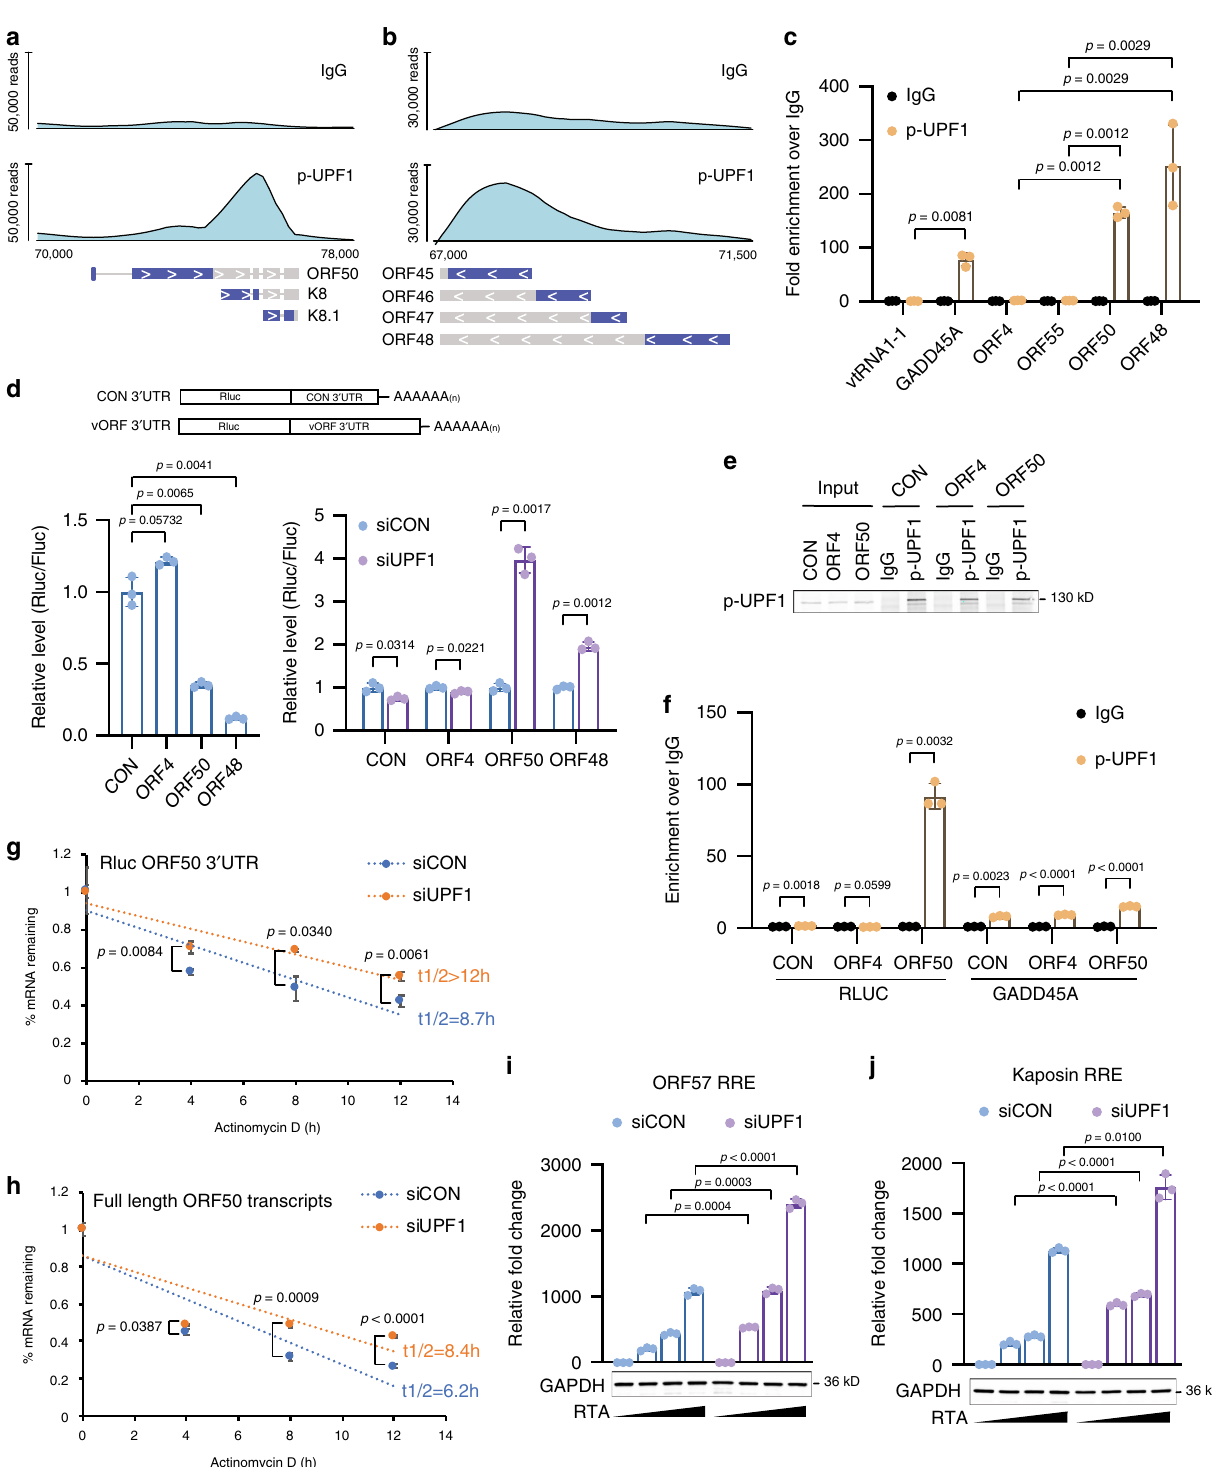
t1/2=6.2ht1/2=8.4ht1/2=8.7ht1/2>12h Fig. 5 NMD targets ORF50 mRNA via its 3 ’ UTR to repress RTA transactivation. a Distribution of p-UPF1 fRIP-seq reads on loci of ORF50-K8.1 gene cluster. b Distribution of p-UPF1 fRIP-seq reads on ORF45-ORF48 gene clusters. c p-UPF1 fRIP-qPCR analysis of indicated viral genes in TREx-BCBL1-RTA cells 48 h post-Dox induction. d Luciferase assay of reporters with control or viral 3 ’ UTR. e Western blot of p-UPF1 fRIP in cells transfected with luciferase reporter containing a control, ORF4 or ORF50 3 ’ UTR. f p-UPF1 fRIP-qPCR analysis of luciferase reporter with control, ORF4 or ORF50 3 ’ UTR. g , h Half-life measurement of the luciferase reporter mRNA with ORF50 3 ’ UTR ( g ) and ORF50 mRNA ( h ) in control and UPF1-depleted HEK293T cells. i , j Luciferase assay quantifying RTA-mediated transactivation of ORF57 ( i ) and kaposin ( j ) in control and UPF1-depleted HEK293T cells. Data are presented as mean values ± SD ( n = 3 biologically independent samples). p -values were determined by the two-tailed Student ’ s t -test. Source data are provided in Source Data fi